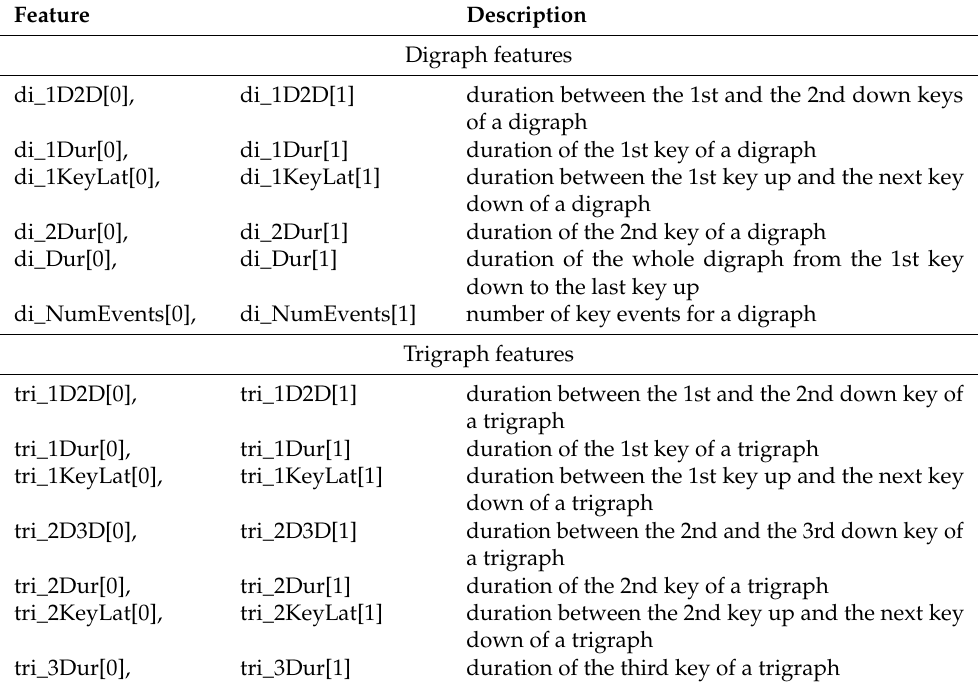
Table 3. Features extracted from raw data. Most features are mean and standard deviation denoted as [0] and [1]